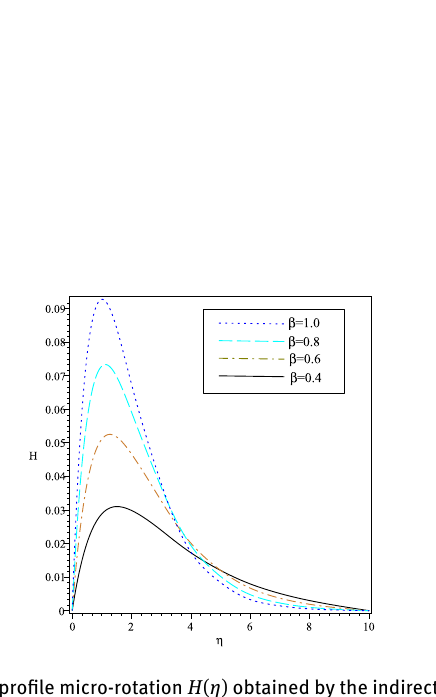
Fig. 7: The profile micro-rotation H ( η ) obtained by the indirect RBFs for different values of β at ϕ = 0 and ε = 0.1 .